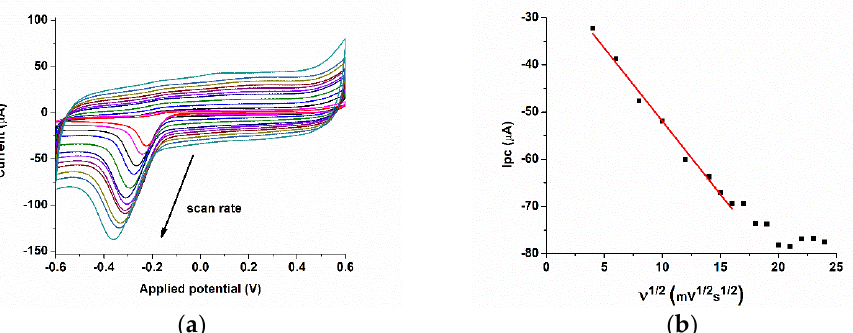
Figure 4. ( a ) Cyclic voltammetry of the SPCE/CoPc electrode for 50 µM PON, PBS pH 12. ( b ) The dependence of the cathodic current (around −0.3 V) with the square root of the scan rate. The SPCE is a three-electrode electrochemical system. The screen-printed area of the carbon-based working electrode (WE, black circle) of the SPCE is 0.126 cm 2 , which is surrounded by the Ag/AgCl pseudoreference electrode (silver) and counter/auxiliary electrode (CE, black). The chemical modification should not cover the CE and the reference electrode, but the surface coverage should be optimal. Starting from a solution of classical concentration for CoPc (1 mg/mL), we drop-casted 1 and 2 µL of the solution on the electrodes and calibrated them by DPV, from −0.4 to 0.3 V, step potential 5 mV, amplitude 25 mV, modulation time 50 ms, scan rate 10 mV/s (Figure 5a). The sensitivity for the 2 µL drop-casted CoPc was 0.083 nA µM −1 , in comparison to 0.057 nA µM −1 for the 1 µL drop- casted CoPc. More than 2 µL is difficult to deposit without covering the other electrodes.